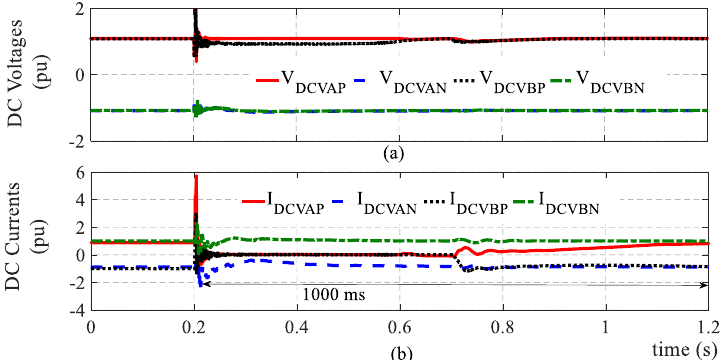
Figure 13. DC measurements at VSC stations for a P-Pole-to-ground fault on main transmission line ( a ) voltages, ( b ) currents.